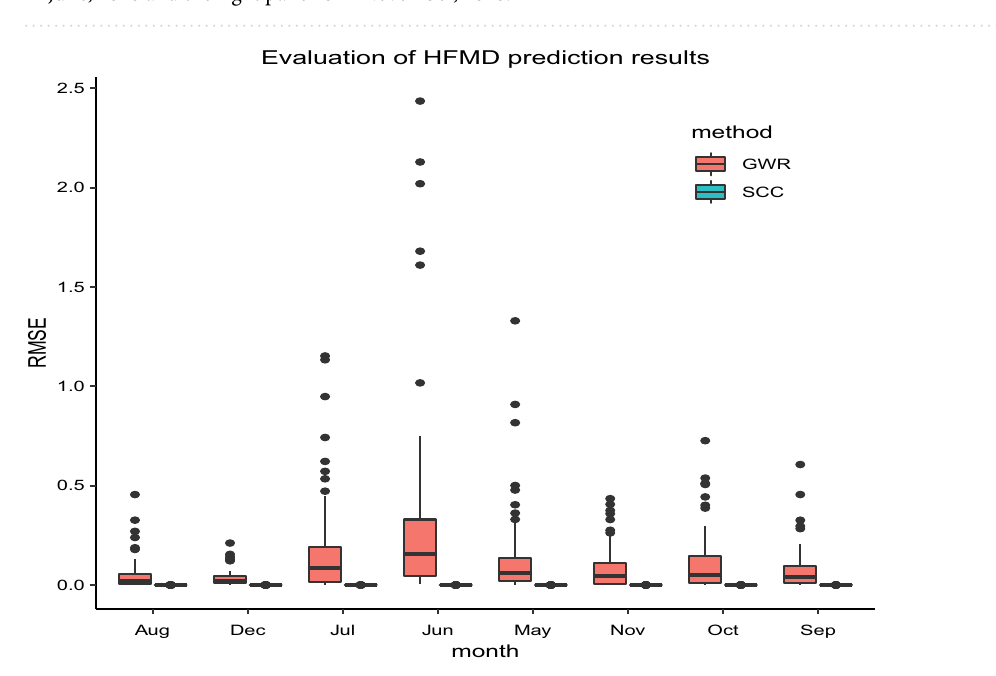
Figure 6. The curve of HFMD incidence estimated based on SCC model and actual incidence, and left panel is in June, 2018 and the right panel is in November, 2018.